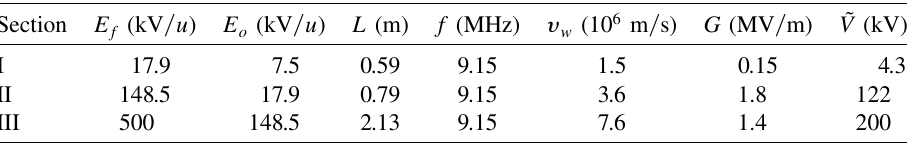
TABLE I. The detailed design parameters of the multipulse PLIA for IMP in Lanzhou.